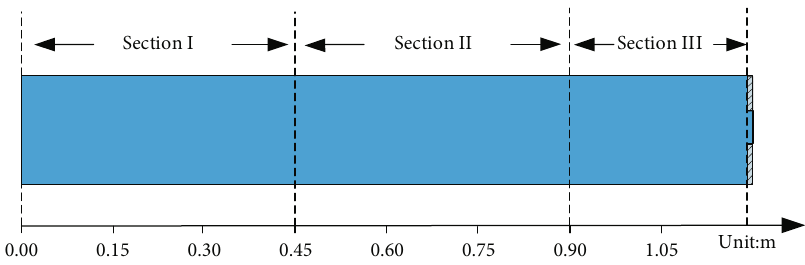
Figure 10: Sections divided in the experimental